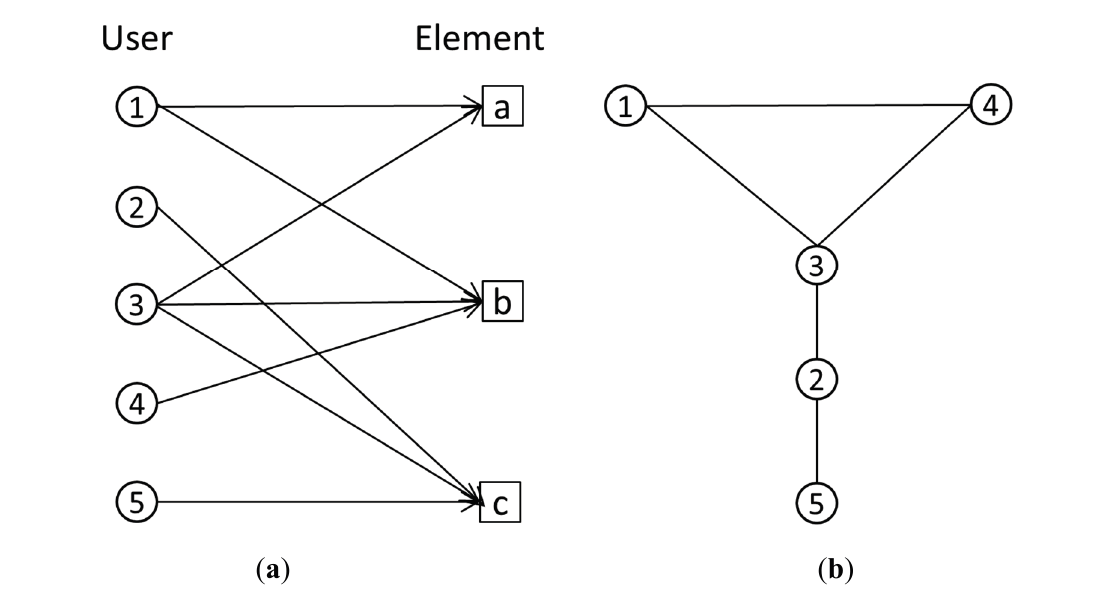
Figure 5. Illustration of co-contribution relationship. Users’ contributions to elements are represented as a bi-partite graph ( a ), which is transformed into a co-contribution network ( b ).